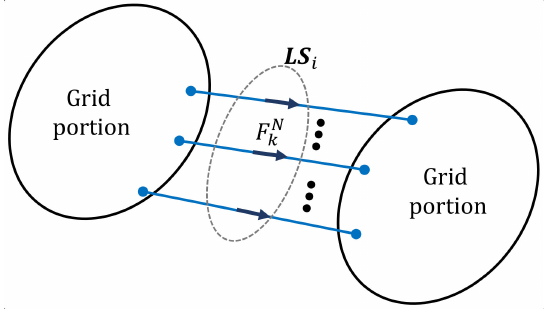
Figure 2. Critical section i